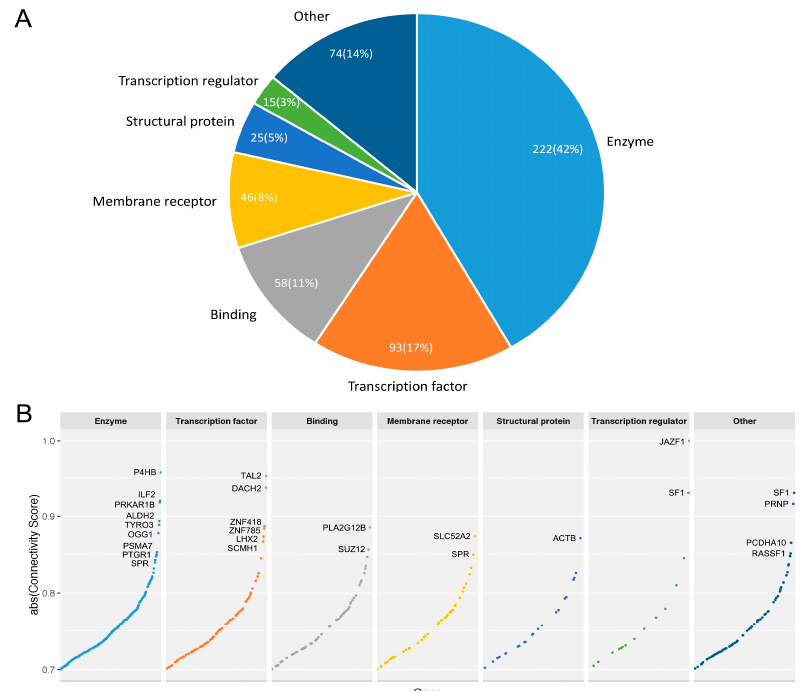
Figure 3. ( A ) Functional classes of protein products from the 510 candidate genes. Enzymes (predominantly kinases) and transcription factors constitute over half the candidate genes. A total of 14% of proteins, here labelled “Other”, fall into classes including transporters, cytokines, splicing factors, kinase activator, etc.; ( B ) Absolute connectivity score of candidate genes in each functional group. Genes with absolute connectivity score above 0.85 are labeled with gene symbols.